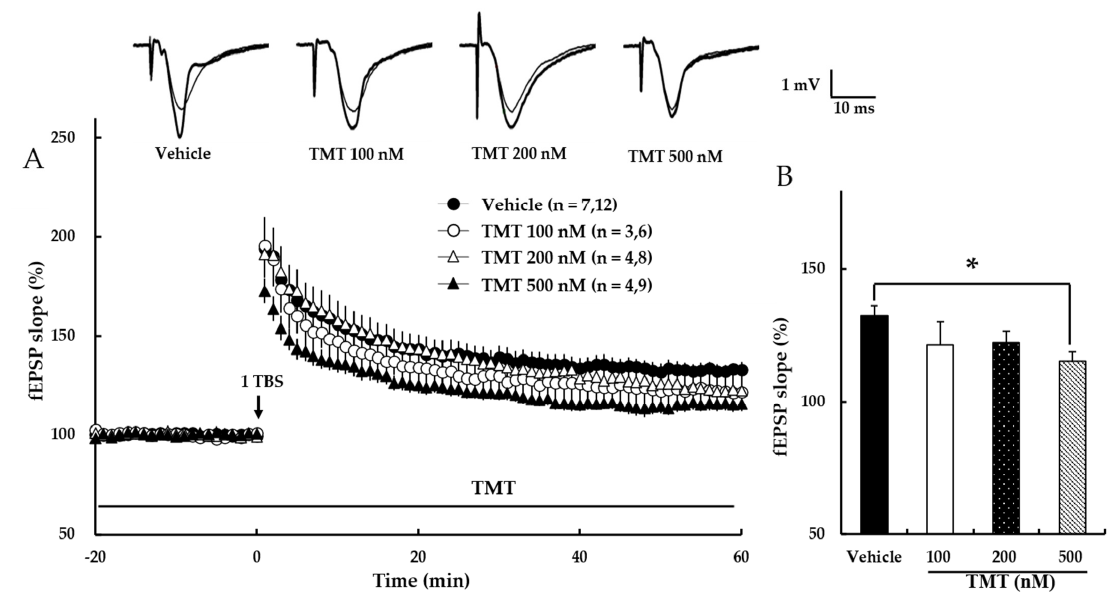
Figure 6. TMT reduces NMDA receptor ‐ dependent LTP in a dose ‐ dependent manner. ( A ) The responses represent LTP induction over 1 h after NMDA receptor-dependent LTP was induced by 1 TBS. TMT in aCSF solution was applied at the beginning of the recording and perfused throughout the time period indicated by the bar. The numbers of mice and slices, respectively, are expressed in parentheses. Filled circles, open circles, open triangles, and filled triangles indicate the Vehicle group, 100 nM TMT group, 200 nM TMT group, and 500 nM TMT group, respectively. ( B ) Values represent percent changes in the fEPSP slope observed at 58–60 min. Statistical significance (* p <0.05 vs. Vehicle) was calculated by one ‐ way ANOVA followed by Tukey HSD test.; fEPSP: field excita ‐ tory synaptic potential.